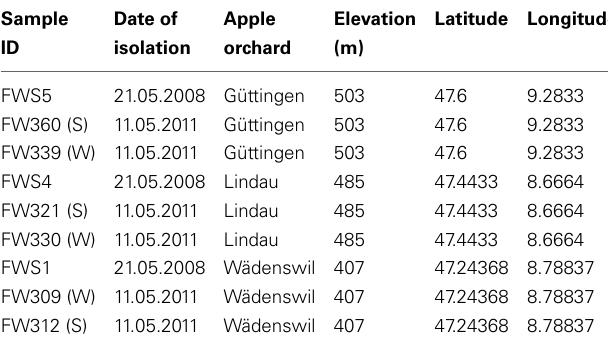
Frontiers in Microbiology | Antimicrobials, Resistance and